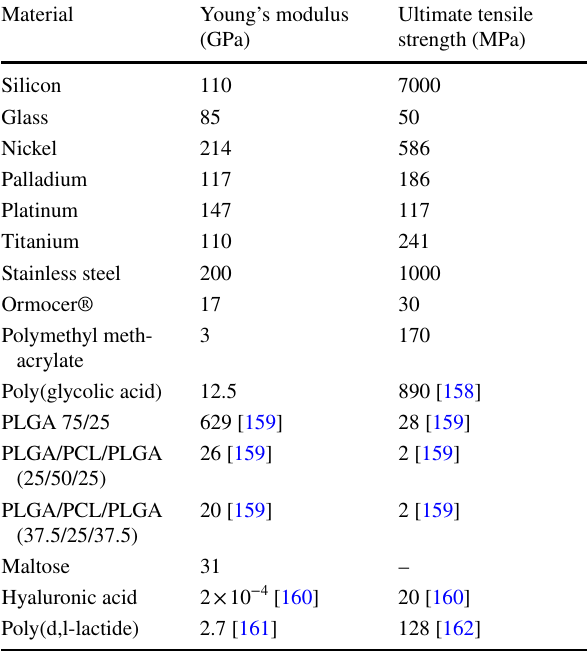
Table 1 Strengths of materials used in microneedle